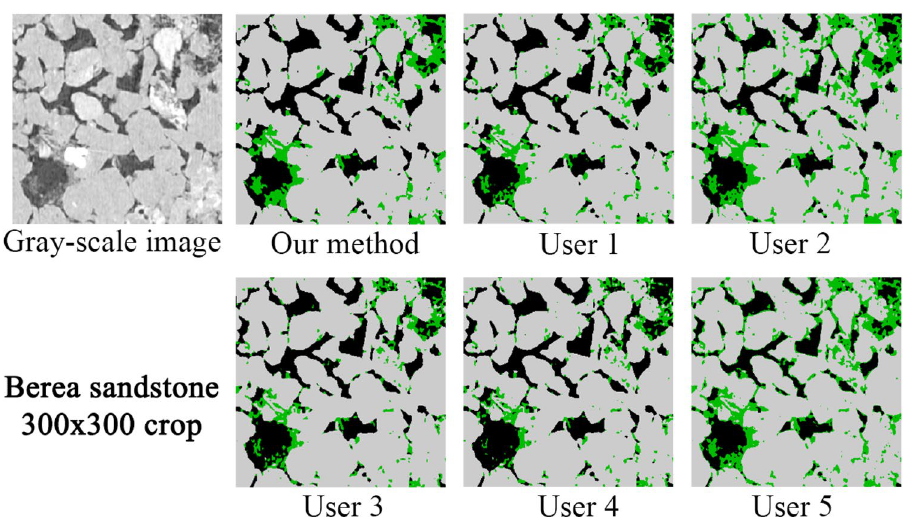
Figure 13. Comparison of segmentation results on a vertical top-half crop of the Berea image where we can see a significant different in the distribution of segmented micro-phase, especially inside the grain